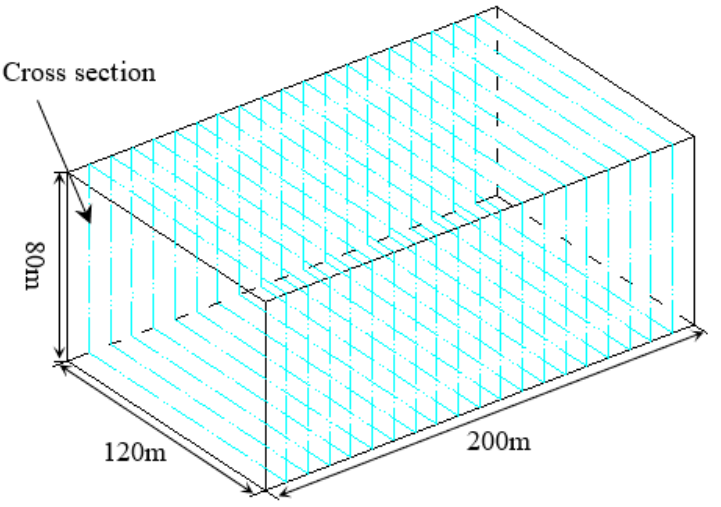
Figure 7. Arrangement of the cross sections in the 3D fracture network model.